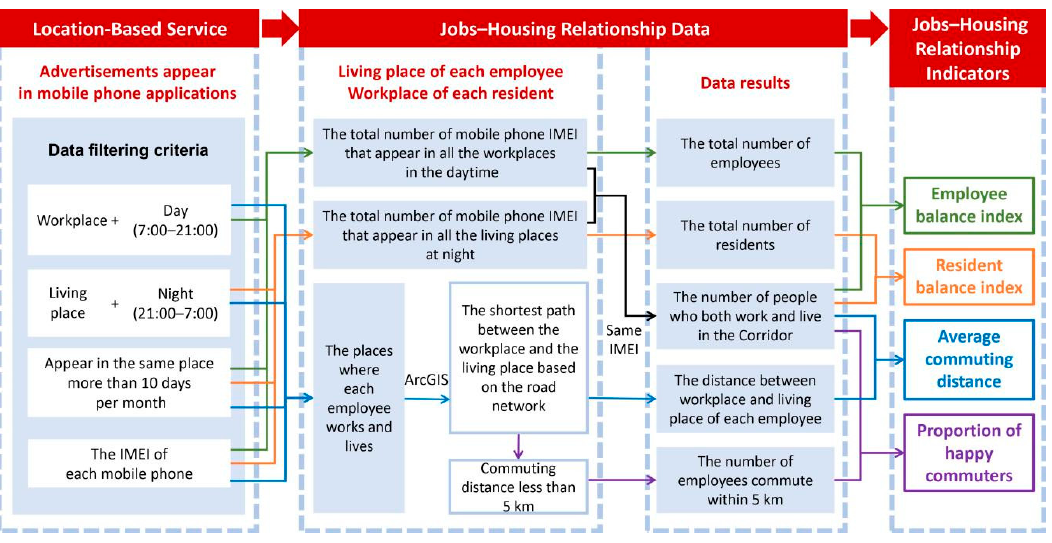
Figure 3. Jobs–Housing relationship indicators based on Location-Based Service (LBS) data. IMEI = international mobile equipment